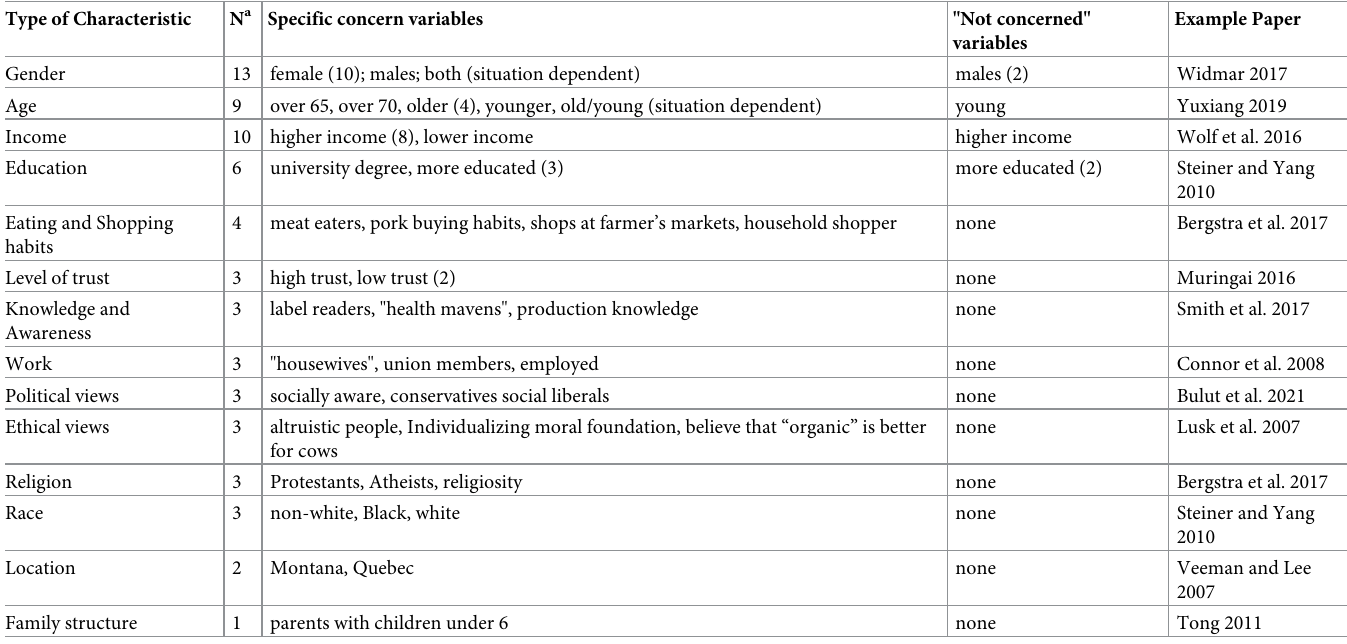
Table 5. Summary of findings from studies that gauged the types of consumers concerned about antibiotic use. Type of